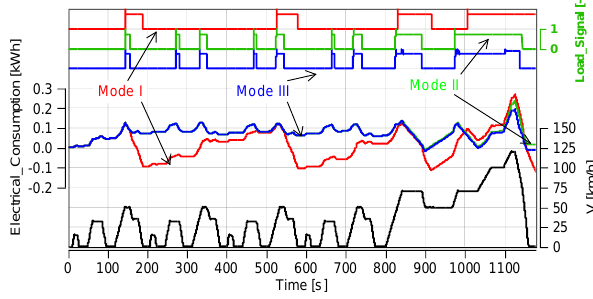
Fig. 9. Internal combustion engine load and electric energy consumption in the NEDC test